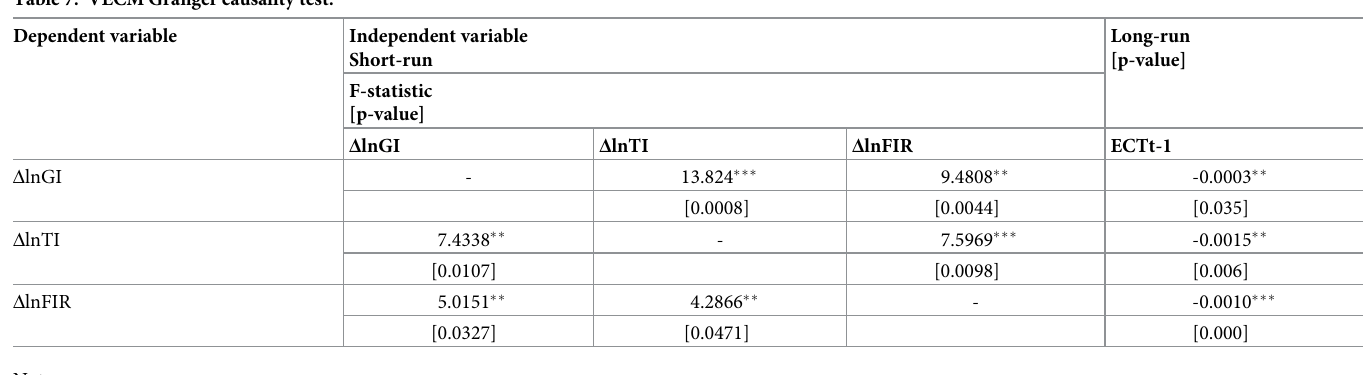
Table 7. VECM Granger causality